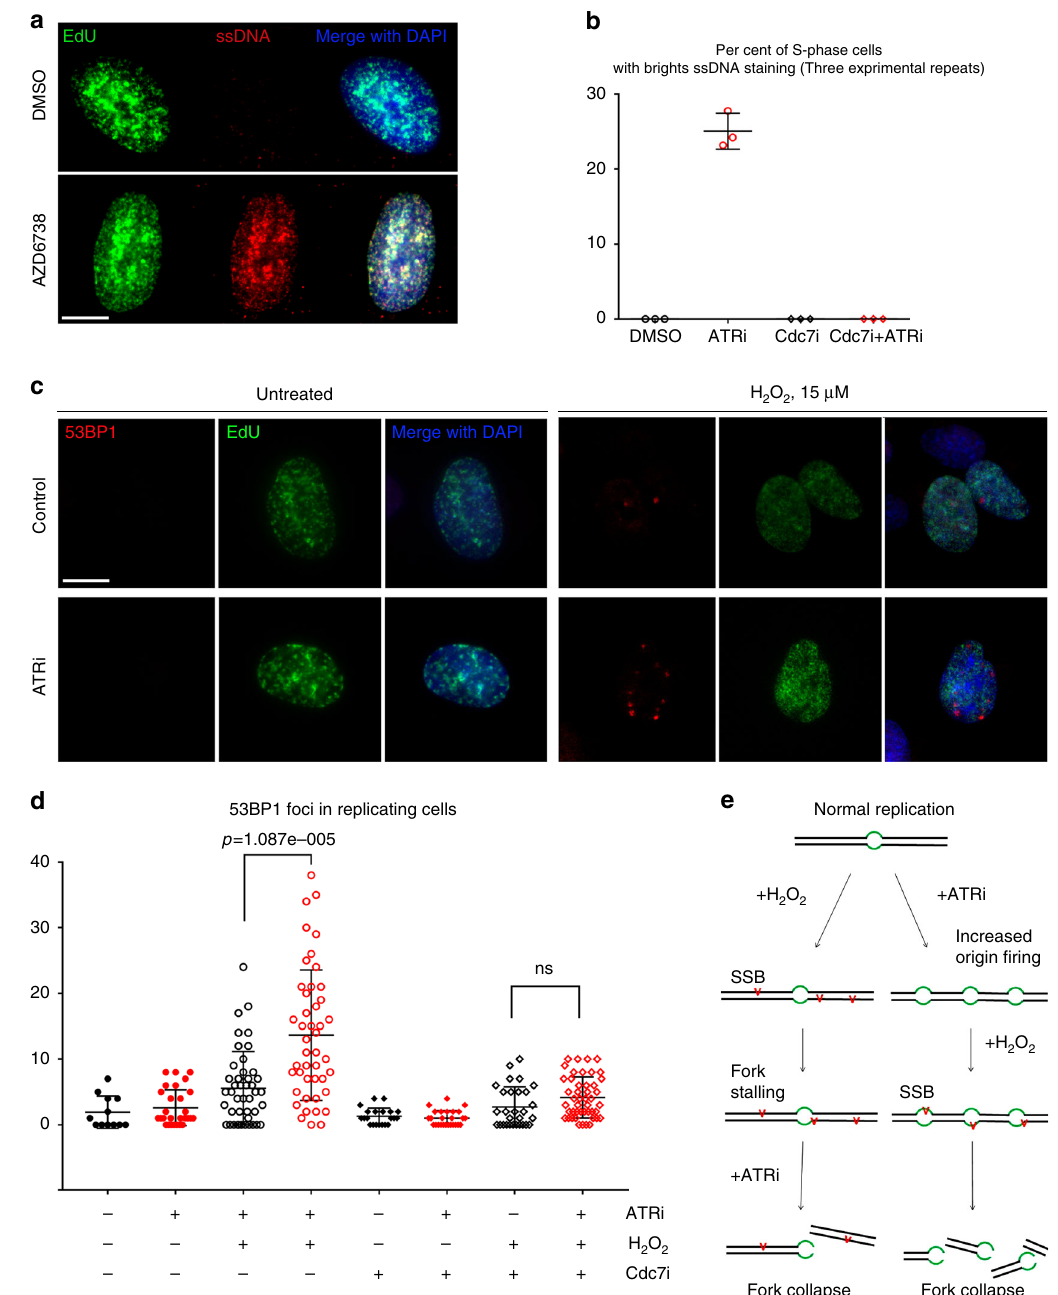
Fig. 4 Prior ATR inhibition increases the number of DNA double-strand breaks induced by hydrogen peroxide. a U2OS cells were incubated with IdU for 24 h before the experiment. EdU of 10 μ M was added 15 ′ before 1 h treatment with 5 μ M AZD/DMSO. Cells were fi xed and stained with anti-BrdU antibody to detect ssDNA followed by click-chemistry reaction to visualize EdU. Scale bar represents 10 μ m. b Quanti fi cation of the previous experiment. For Cdc7i samples, 10 μ M Cdc7i was added at the same time as EdU. Error bars represent standard deviation. c BJ-hTERT fi broblasts were treated with vehicle or 5 μ M ATRi (AZD6738) for 45 min before the addition of 15 μ M H μ M EdU to label replicating cells. Cells were fi xed 30 min after adding H 2 O 2 and 10 2 O 2 . 53BP1 was detected by indirect immuno fl uorescence; EdU was detected by click-chemistry reaction. Representative images are shown. Scale bar represents 10 μ m. d As in c , but Cdc7 inhibitor was added 15 min before ATRi. Numbers of 53BP1 foci per cell were determined. Three experimental repeats were performed and showed similar results; quanti fi cation of one is shown. e Schematic representation of a model: sequence of administration of ATRi